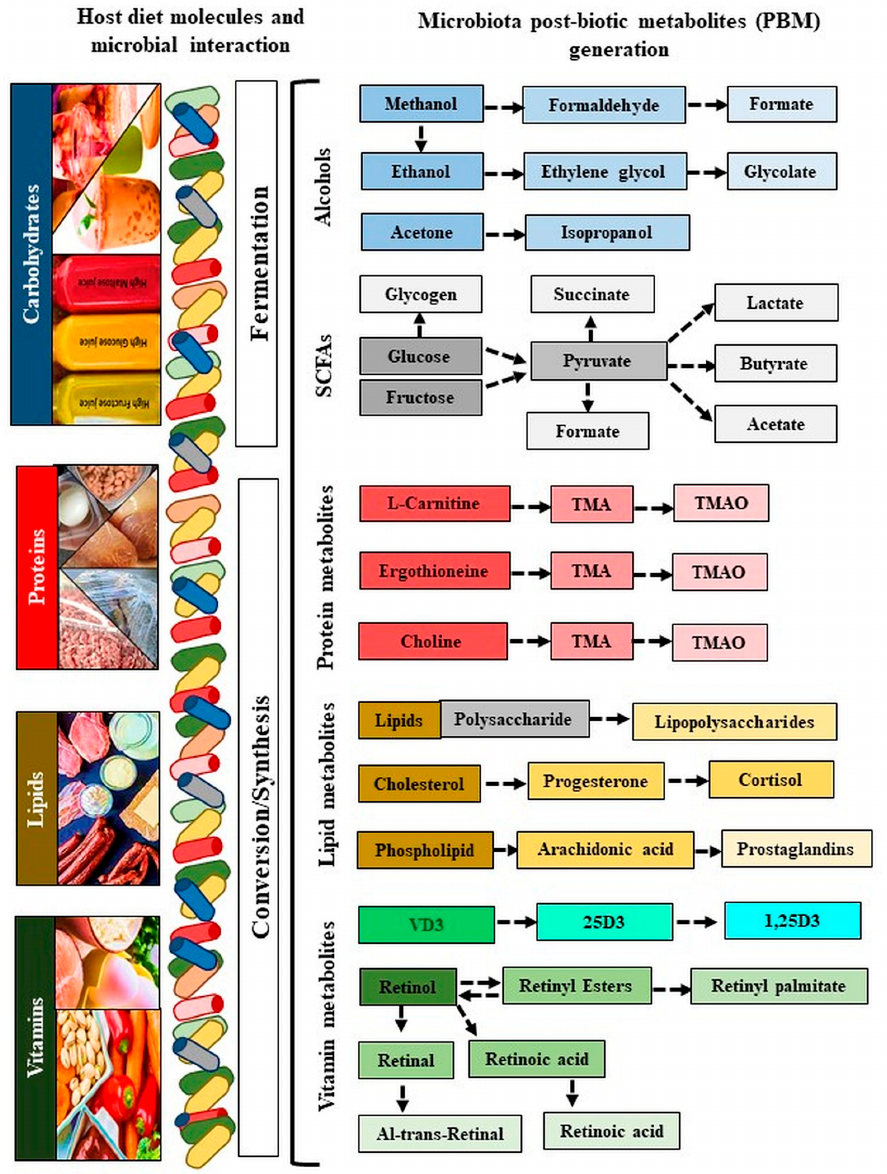
Figure 3. Generation of microbiota metabolites. The blue color refers to carbohydrates, the red color refers to proteins, the yellow color refers to lipids, and the green color refers to vitamins. Colors indicate metabolites generated by their specific diatery molecules and microbiota. Colors from dark to light color shed indicate derivatives of metabolites conversion. VD: Vitamin D; 25D: 25-hydroxy vitamin D; 1,25(OH)2D3: 1 α ,25-dihydroxy vitamin